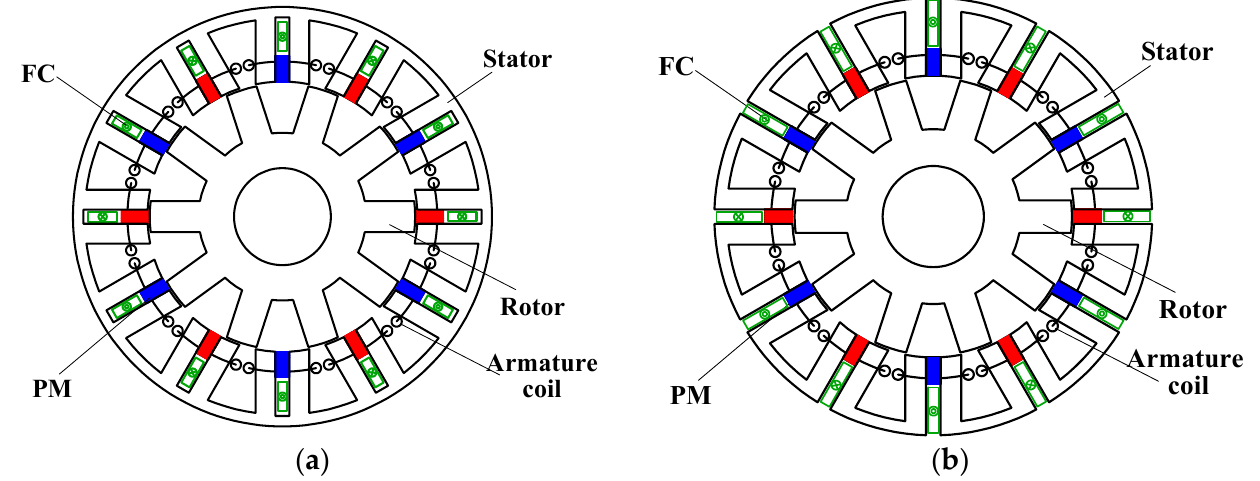
Figure 9. Cross section of a parallel stator ‐ excited HE machine with bipolar flux ( a ) with iron Figure 8. Cross section of a parallel stator-excited HE machine with bipolar flux ( a ) with iron bridge bridge for parallel coupling [45] and ( b ) without iron bridge for series coupling [47]. for parallel coupling [45] and ( b ) without iron bridge for series coupling